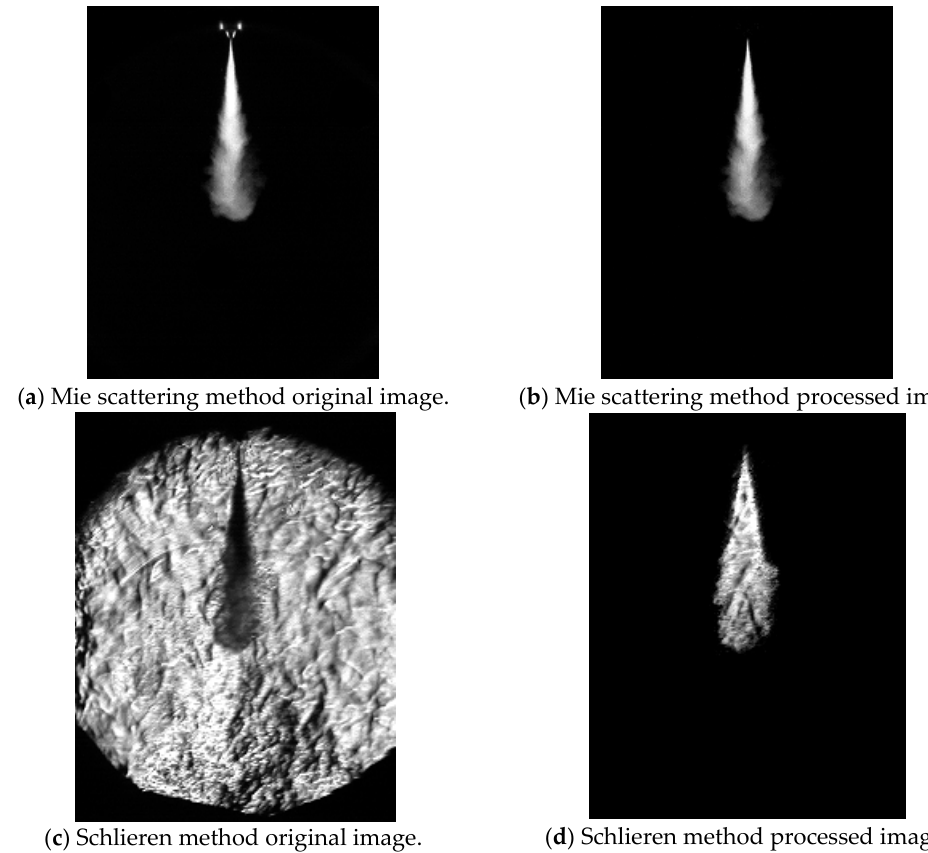
Figure 4. Comparison of processed and raw images using Mie scattering and schlieren methods.